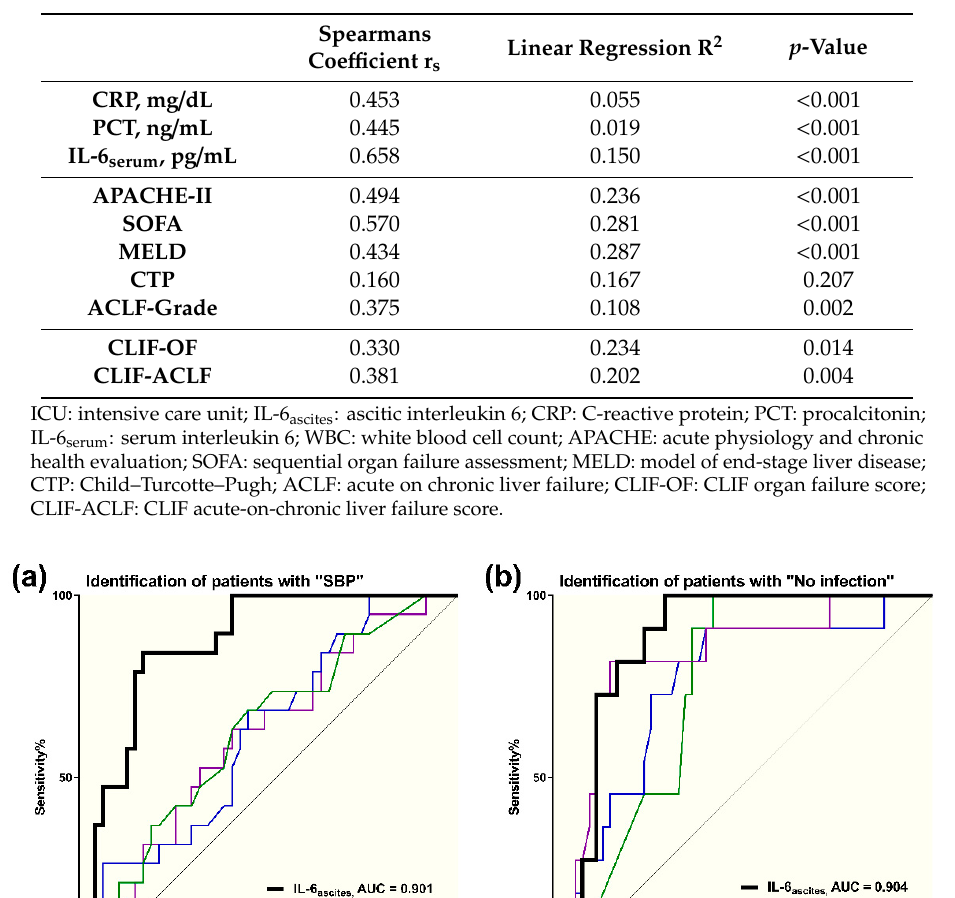
Table 3. Correlations and linear regressions of baseline ascitic interleukin 6 (IL-6 ascites ) with laboratory parameters and clinical scores on admission to ICU.